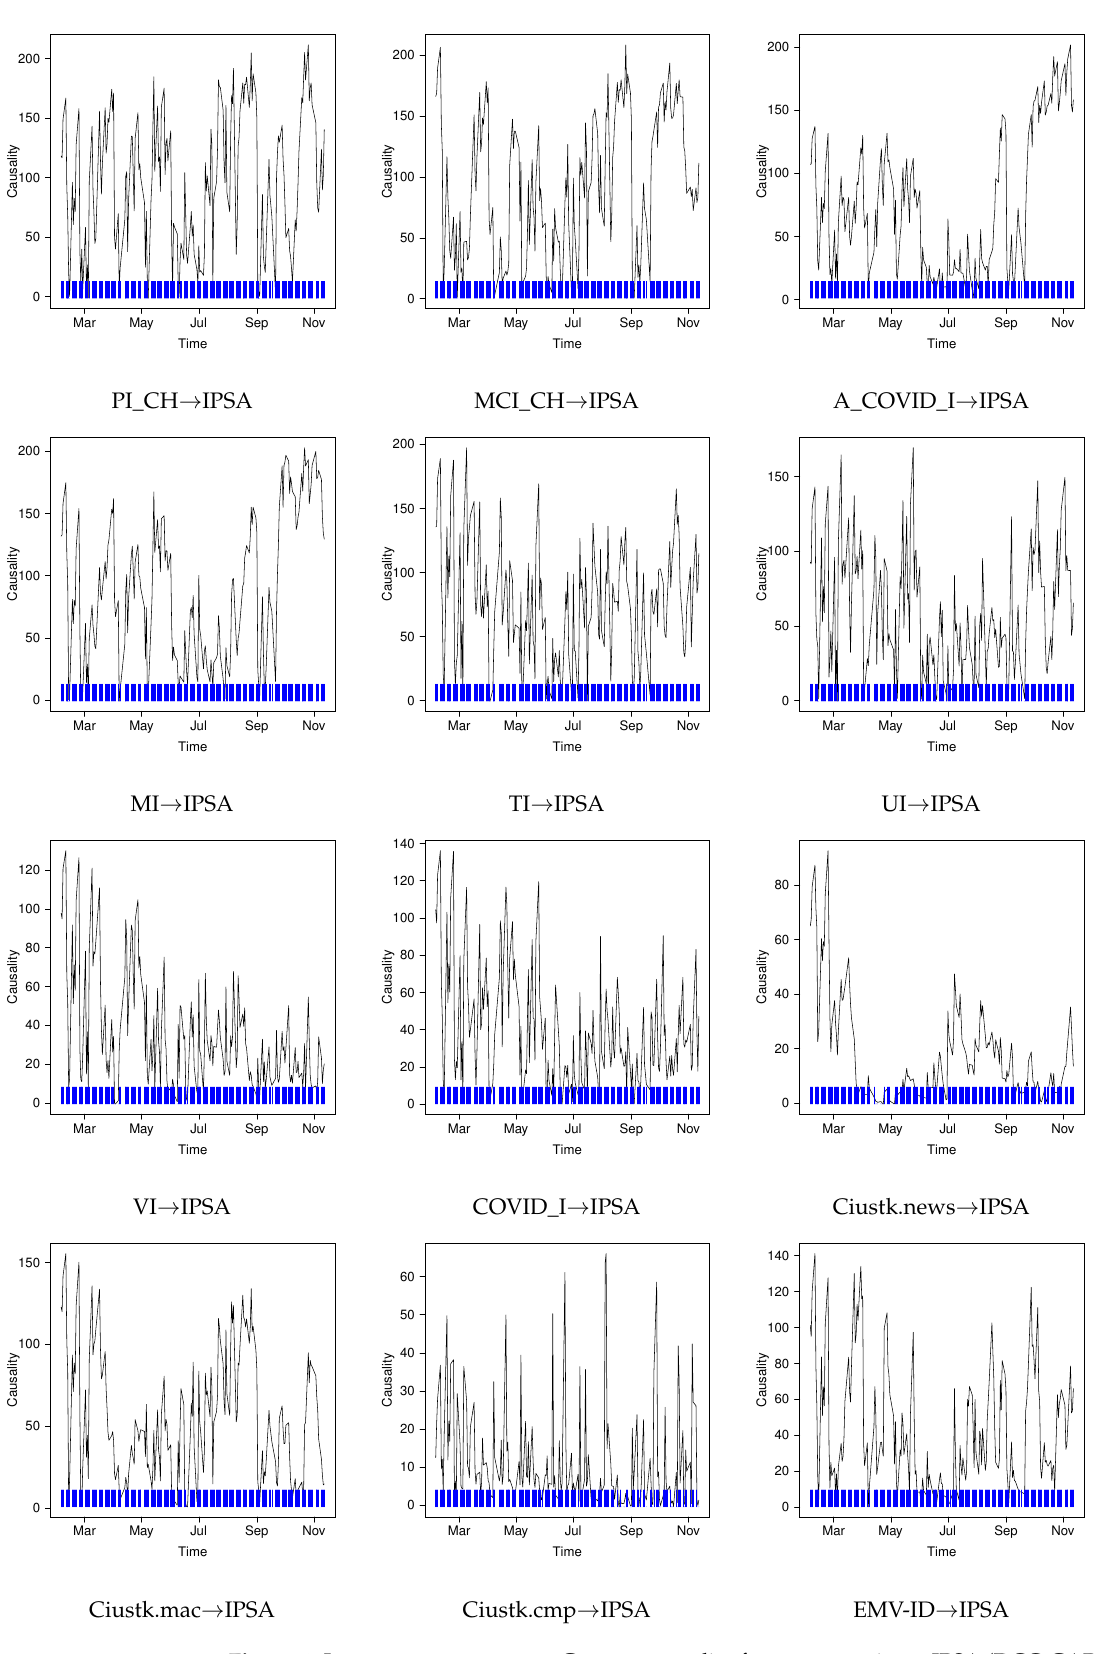
Figure 4. Instantaneous, one-way Granger-causality from news series to IPSA (DCC-GARCH